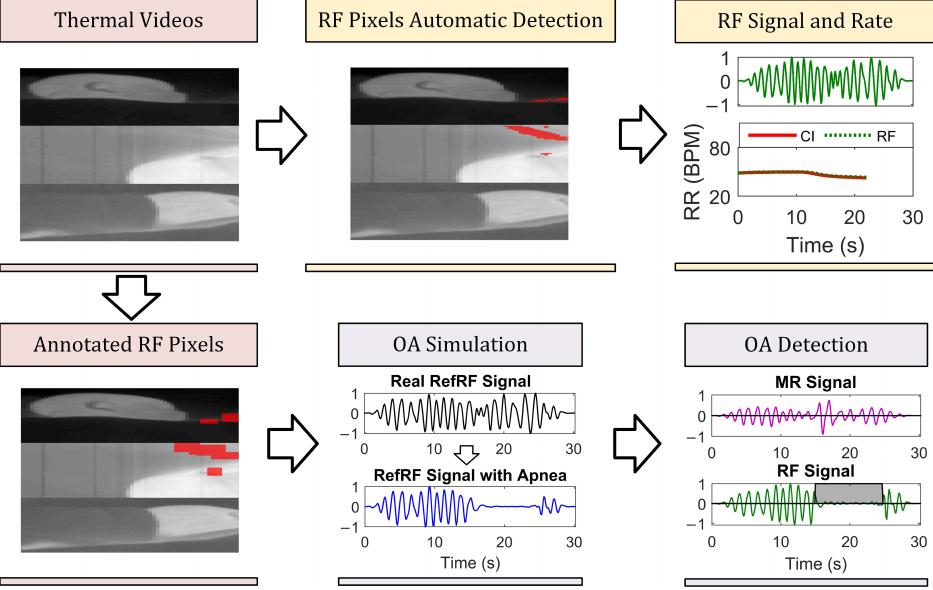
Figure 4. Summary of the processing and example results. RF pixels are automatically detected in the thermal videos and used to calculate the RF signal and the flow-based RR. Moreover, the RF pixel location is manually annotated. The annotated RF pixels are substituted with noise to simulate the occurrence of an OA. A COB-detector is used to compare the performance in OA detectability between the RF signal and the MR signal . The thermal frames shown are a vertical combination of three cameras visualizing the infant from different points of